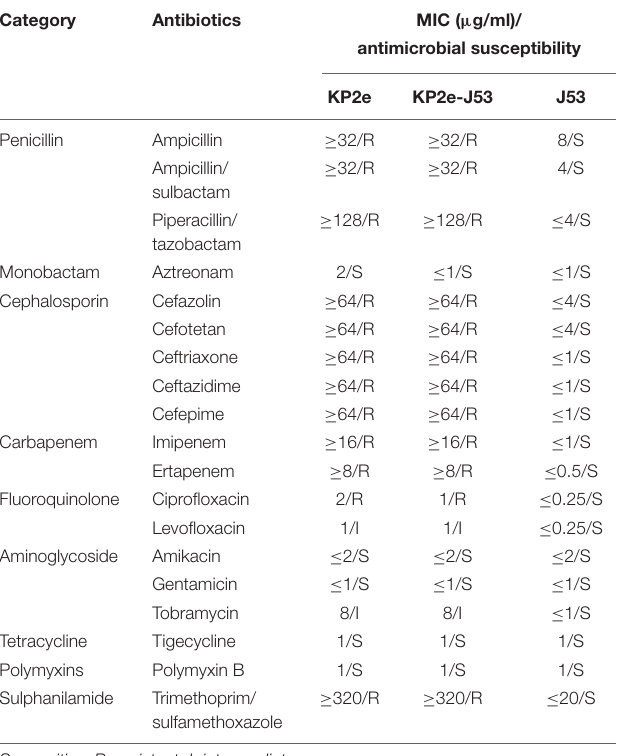
TABLE 1 | Minimum inhibitory concentration values of antimicrobials for KP2e, recipient strain E. coli J53 and transconjugant KP2e-J53.